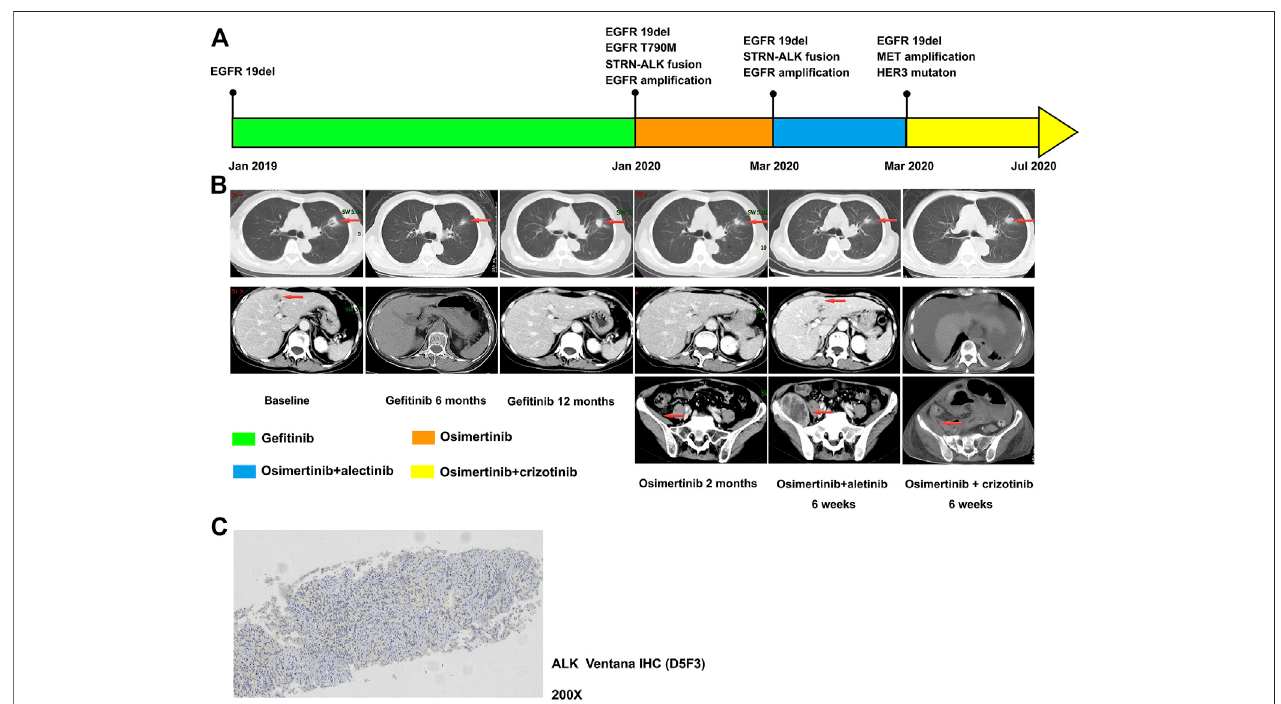
FIGURE 1 | (A) : Timer shaft of gene testing and treatment measurement of case 1; (B) : Computed tomographic images of primary lung lesion, liver, and iliopsoas mass metastases; (C) : ALK Ventana immunohistochemistry (D5F3) as